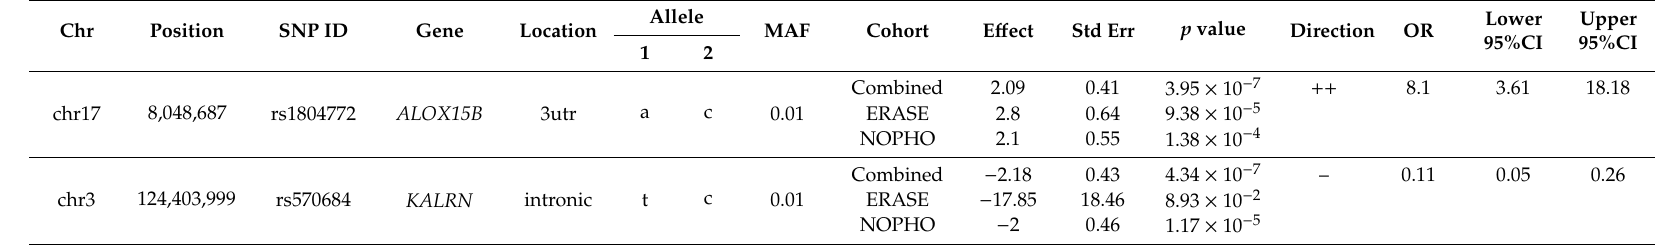
Table 2. Top single-nucleotide polymorphisms (SNPs) in VTE meta-analysis, p < 1 × 10 − 6 . Top SNPs associated with risk of VTE in ALL / LBL (note only